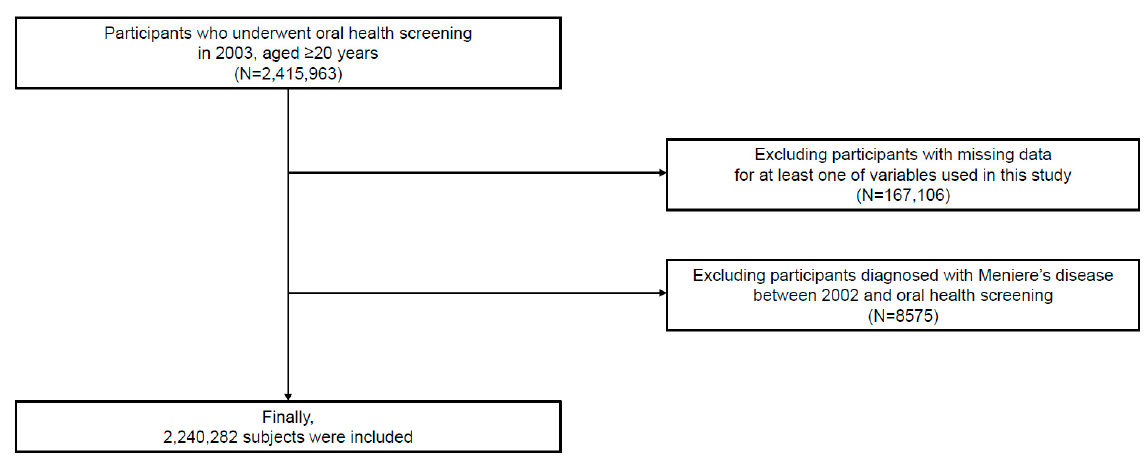
Figure 1. Flow chart of the study participants.